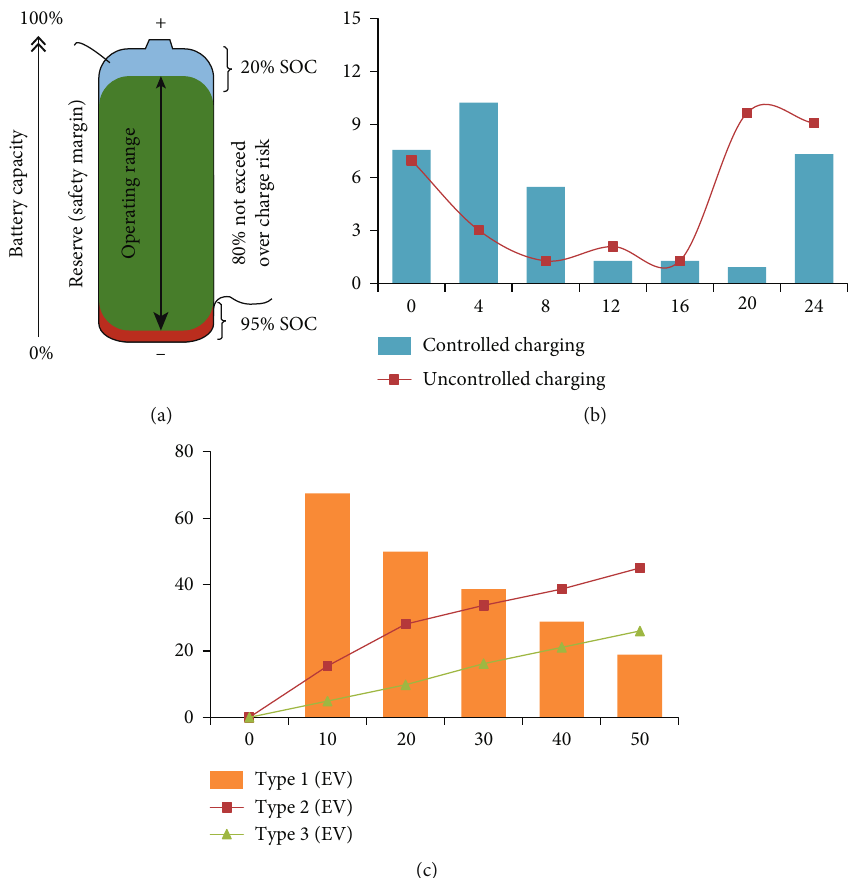
Figure 7: Charging schedule of EVs. Redrawn from this source [58]. (a) EV battery capacity. (b) Charging is limited during peak times. (c) Charging process is completed before 6